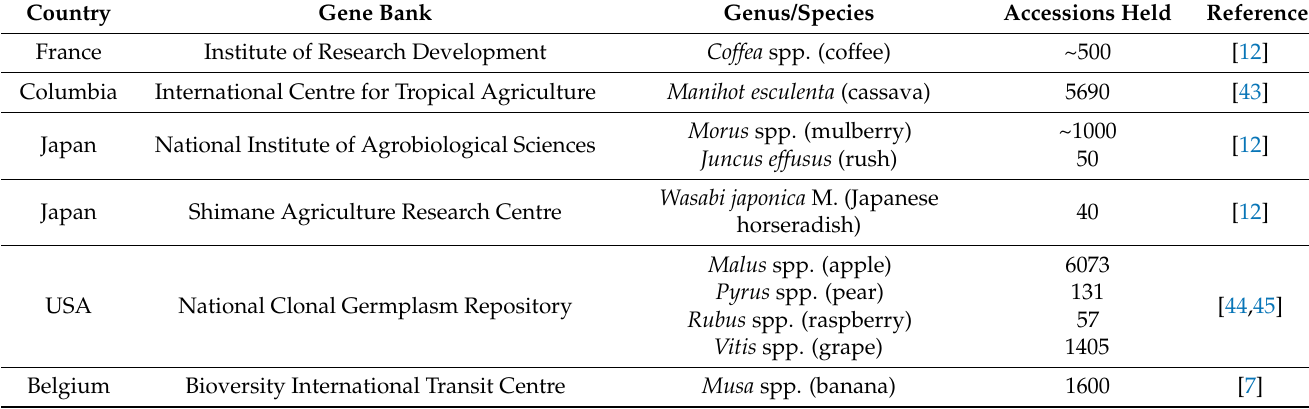
Table 2. Some examples of cryo-storage gene banks maintaining collections of economically important crops.